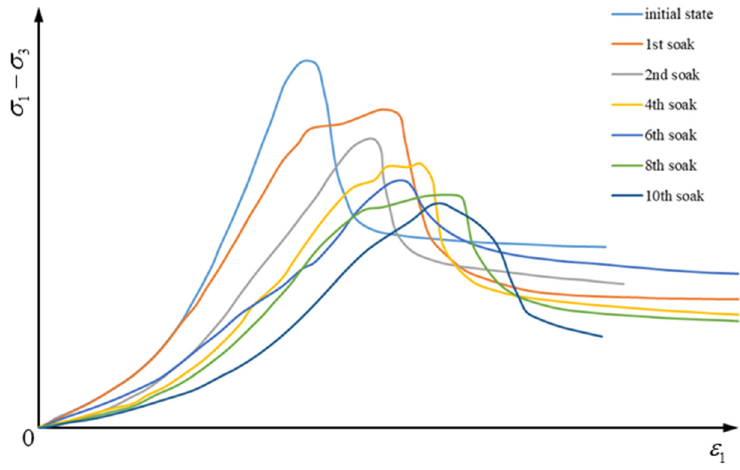
Figure 5. Unloading stress-strain curves of typical rock under water–rock